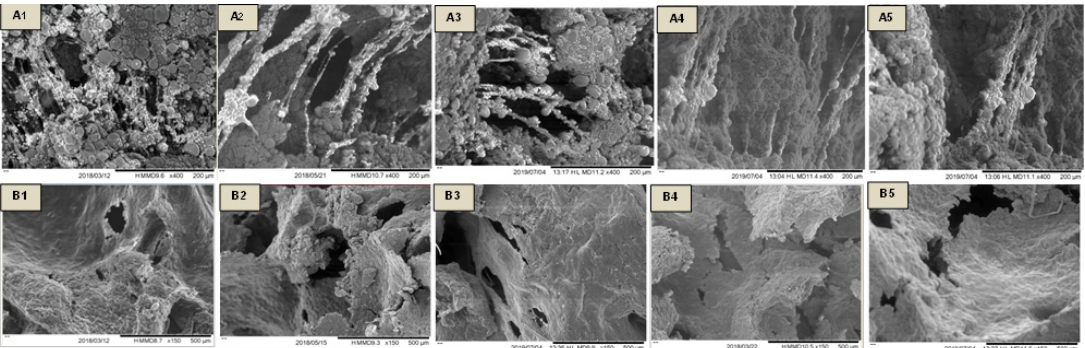
Figure 5. Scanning electron micrographs (400 × , scale bar = 200 µ m for dough; 150 × , scale bar = 500 µ m for bread crumb): A—fermented dough (60 min / 37 ◦ C); A1 —Control dough; A2 —30 g Yg, A3—50 g Yg; A4—30 g Cc, A5—50 g Cc; B—breads: B1—control bread, B2—30 g Yg, B3—50 g Yg ; B4—30